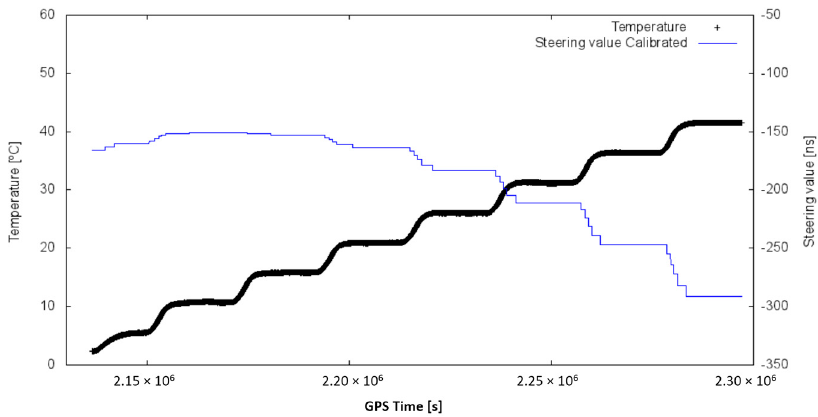
Figure 10. Steering and temperature vs. time.